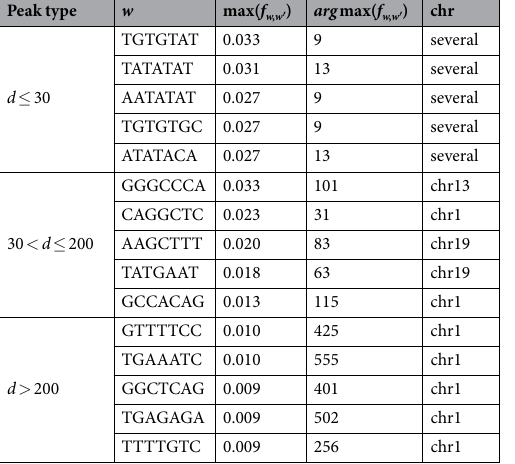
Table 4. Words with highest f w , w ′ maximum, with indication of the maximising distance, in masked sequences, organised by peak type: d ≤ 30, 30 < d ≤ 200 and d > 200.